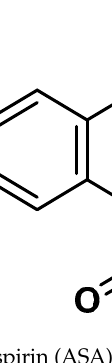
Figure 1. Structure of methylseleno-aspirin (ASA) analog (2-([methylselanyl]carbonyl)phenyl acetate, 1a